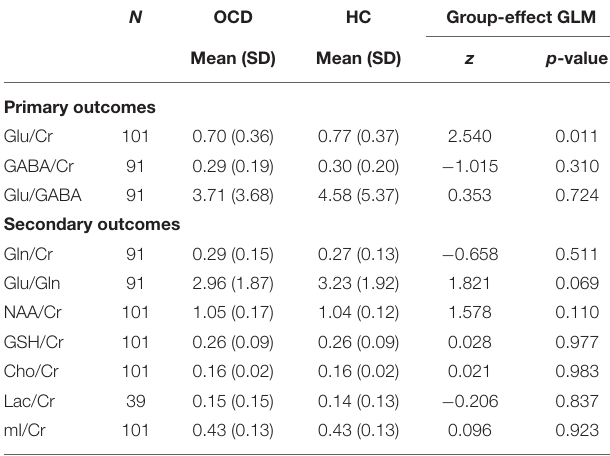
TABLE 2 | Ventromedial PFC metabolites levels in patients with TABLE 1 | Clinical and demographic variables in patients with obsessive-compulsive disorder and healthy obsessive-compulsive disorder and healthy controls. Patients Controls t / X 2